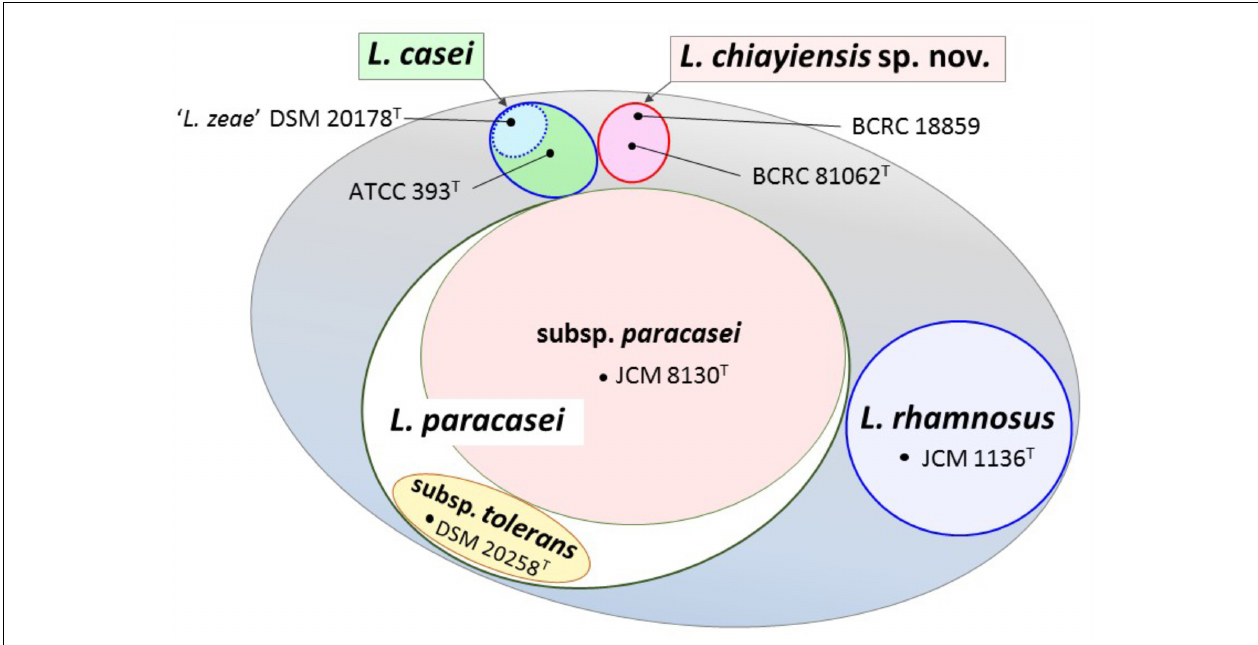
FIGURE 5 | View showing the current state in classification of the L. casei group. The L. casei group has at least four distinct species; L. casei , L. chiayiensis sp. nov., L. paracasei , and L. rhamnosus . L. paracasei is comprised of two subspecies; L. paracasei subsp. paracasei and L. paracasei subsp. tolerans . ‘ L. zeae ’ has a possibility to be reclassified as the independent new